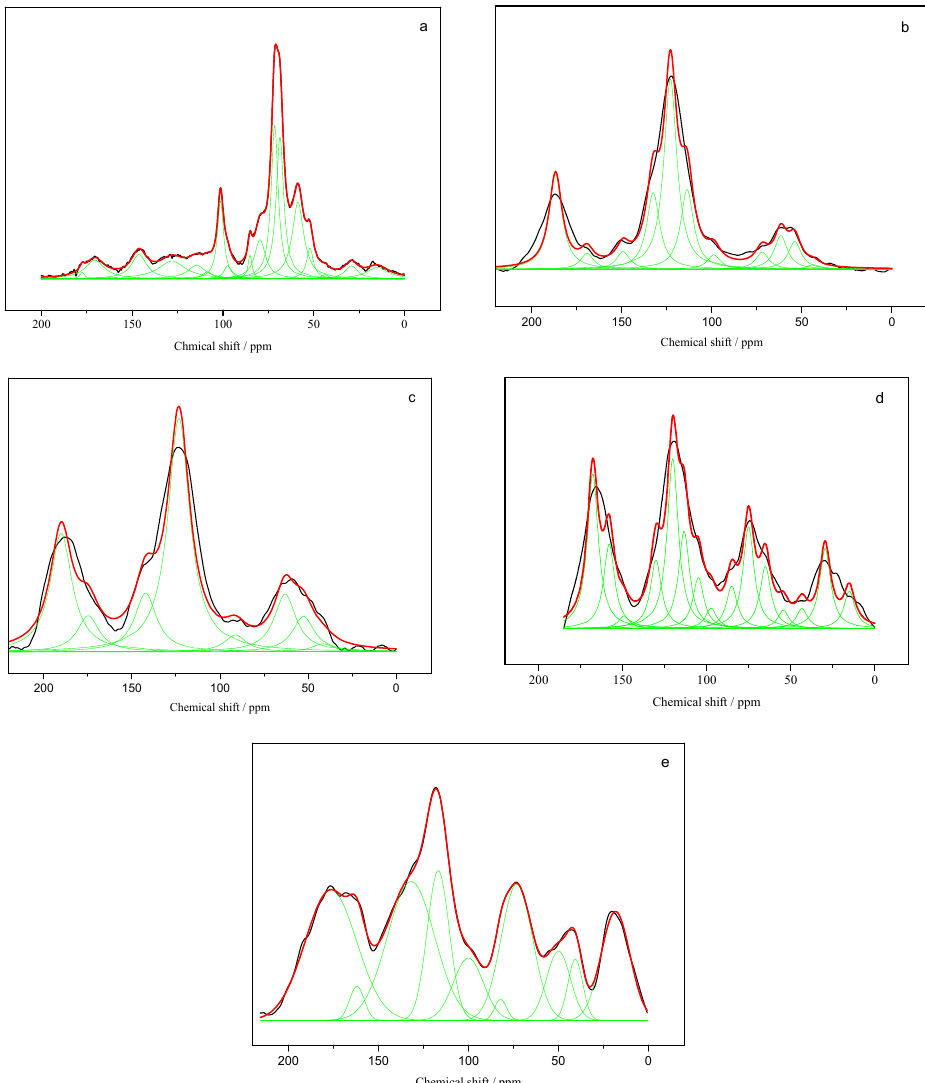
Figure 4. Fitting 13 C-NMR curves of samples: ( a ) pine, ( b ) PC-500, ( c ) PC-700, ( d ) PADC-500, and ( e ) PADC-700.